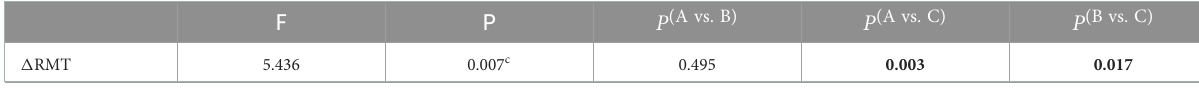
TABLE 8 Pairwise comparison of RMT differences before and after treatment among three groups. F